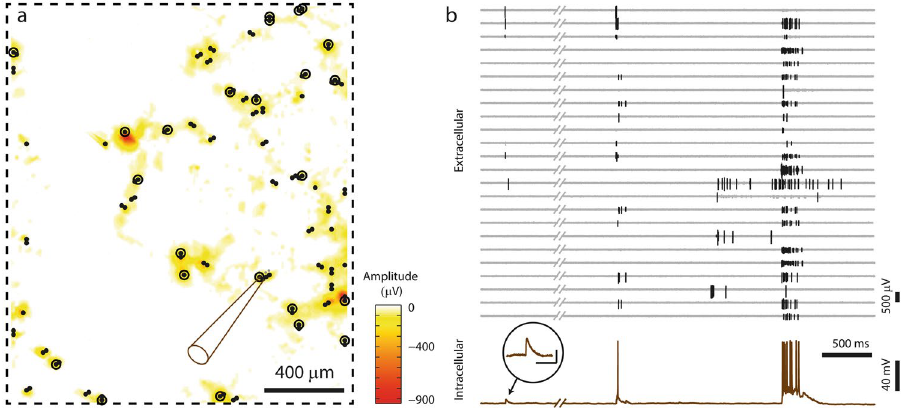
Figure 3. Simultaneous recording of network activity and intracellular activity. ( a ) Visualization of the array area (dashed box), and the corresponding SSAM. A neuron (position indicated by pipette drawing) was recorded intracellularly, while spontaneous extracellular activity was recorded by sparsely distributed electrodes (all recording electrodes are marked with black spots, while circled dots indicate the subset of electrodes, the signals of which are shown in ( b )). ( b ) Top : Extracellular signals (detected spikes) of 24 electrodes distributed over the array at the locations of the circled dots in ( a ). Bottom : Intracellular signal of the patched neuron. The close-up shows an individual, enlarged PSP (scale bars 100 ms/4